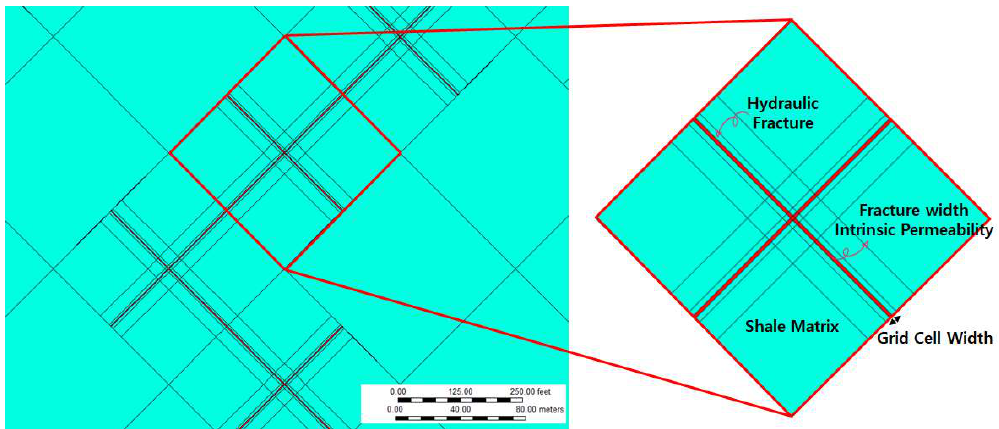
Figure 10. LS-LR-DK (logarithmically spaced, locally refined, dual permeability).